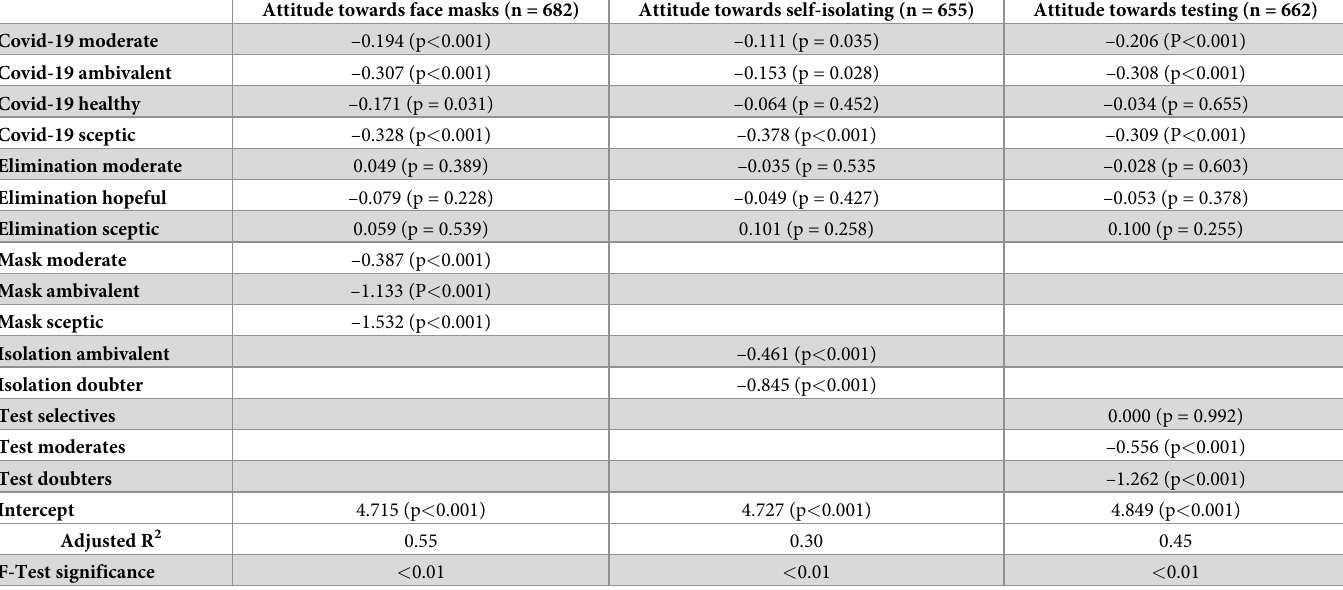
Table 11. Parameter estimates for attitude towards wearing face masks, self-isolating and seeking